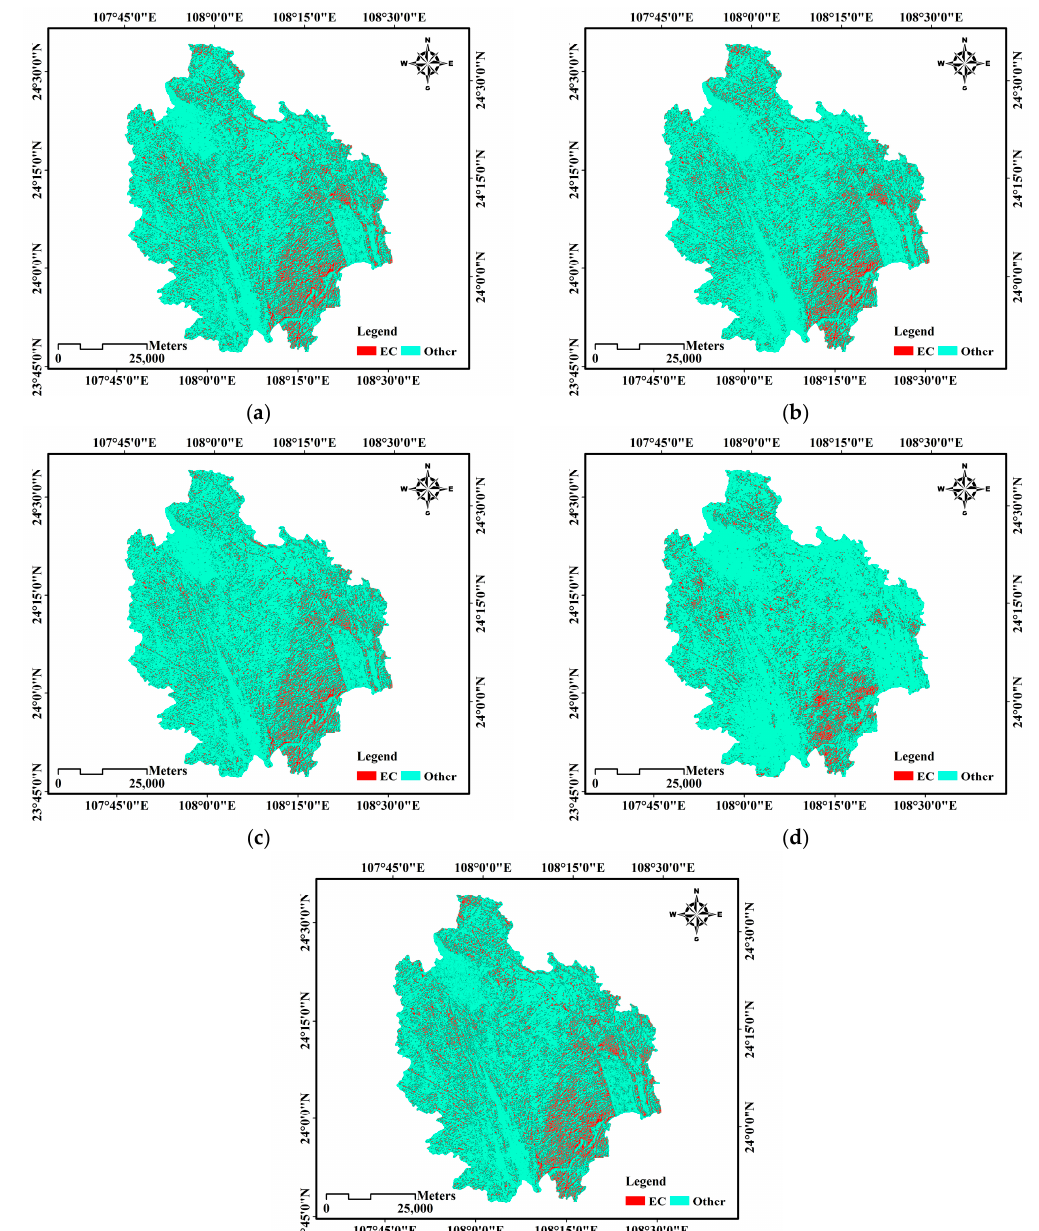
Figure 11. The extraction results of exposed carbonatite in the second test area by: ( a ) the proposed method; ( b ) CL-DT; ( c ) SAE; ( d ) CART; and ( e ) RFs.